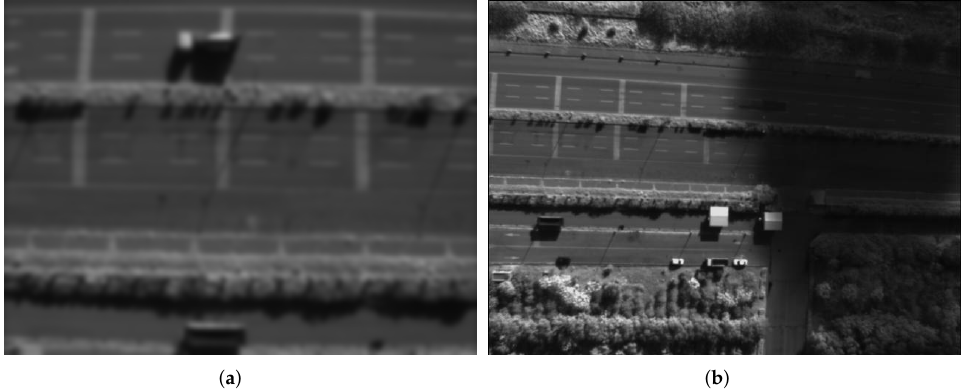
Figure 1. Flawed SWIR images captured during the aerial remote-sensing result in re-executing the aerial remote-sensing task. ( a ) Blurred SWIR image. ( b ) Shadow caused by